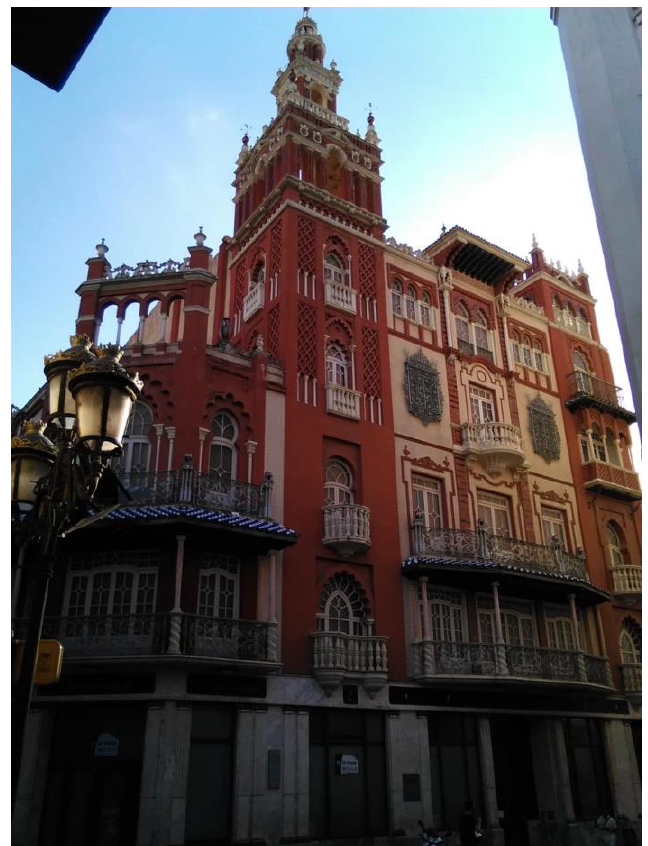
Figure 4. Façade of the building of Manuel Cancho Moreno, known as La Giralda (1923). Badajoz.